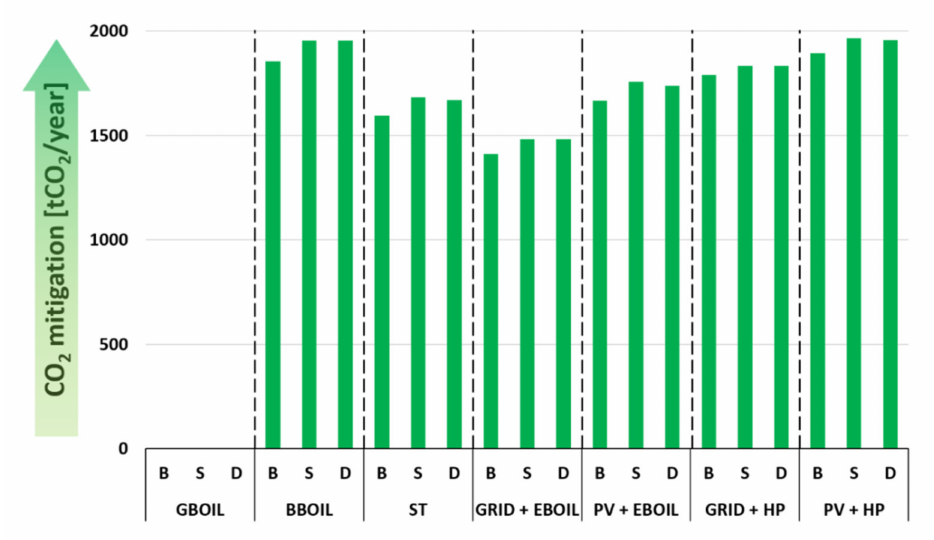
Figure 5. Overall CO 2 mitigation for every solution at every